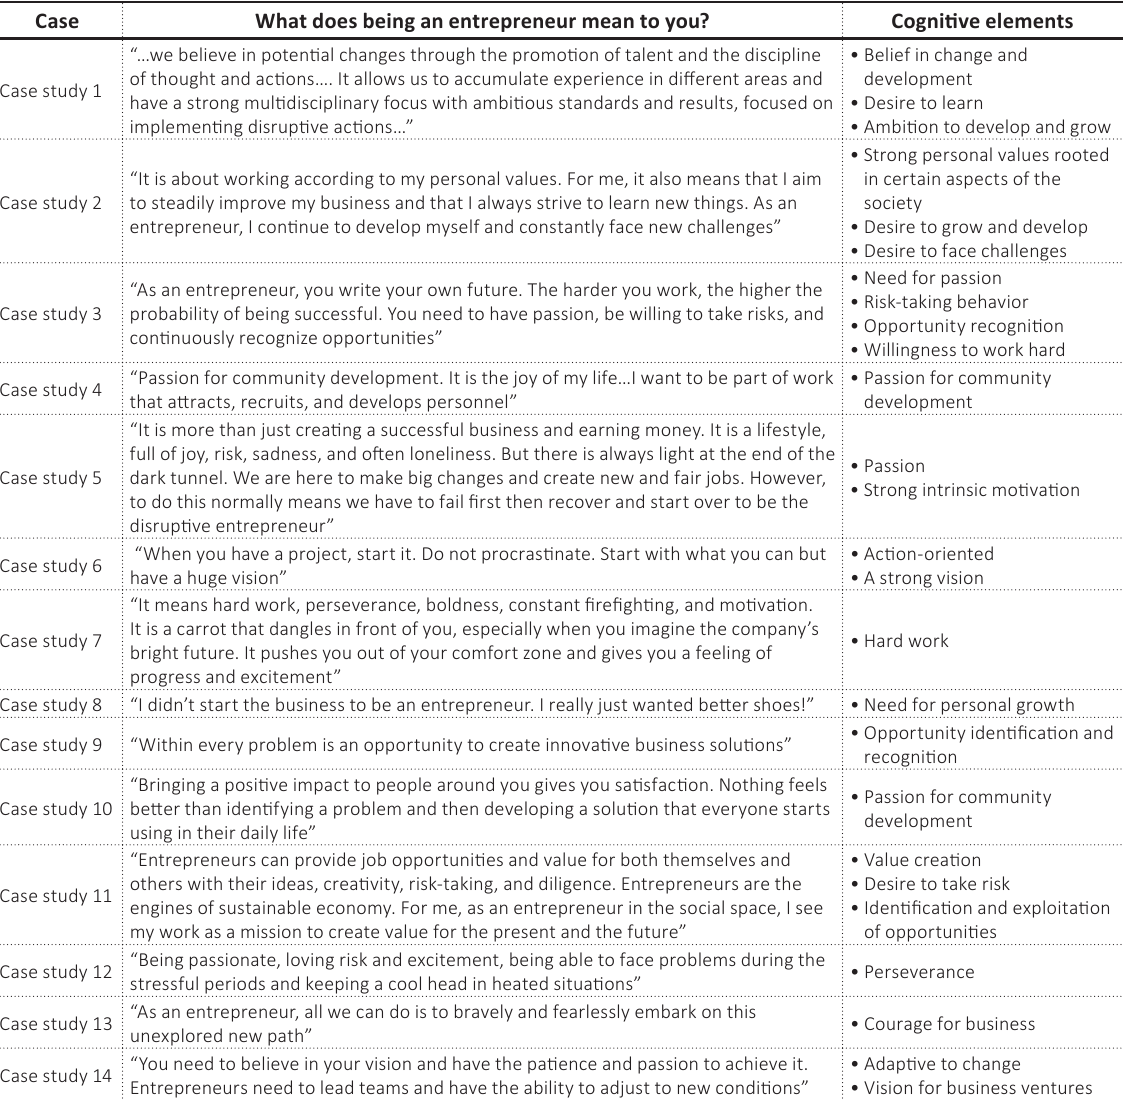
Table 1. Analysis of the secondary data